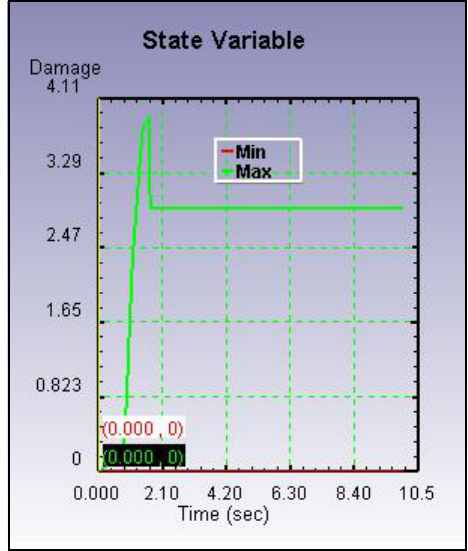
Figure 15. Evolution of damage in the core of the part. Table 14. Taguchi’s orthogonal array for damage factor.